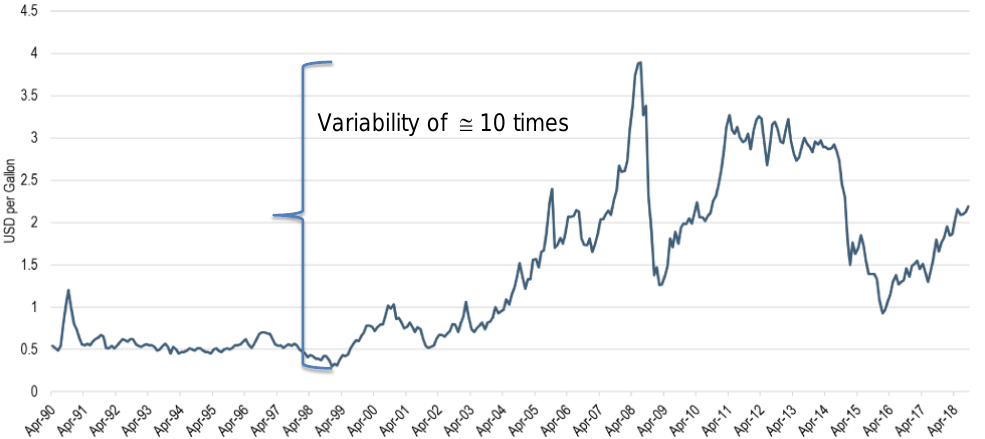
Figure 10. Variation in the price of kerosene over the last few decades (US Energy Information Administration, U.S. Gulf Coast Kerosene-Type Jet Fuel Spot Price FOB, USD per gallon).